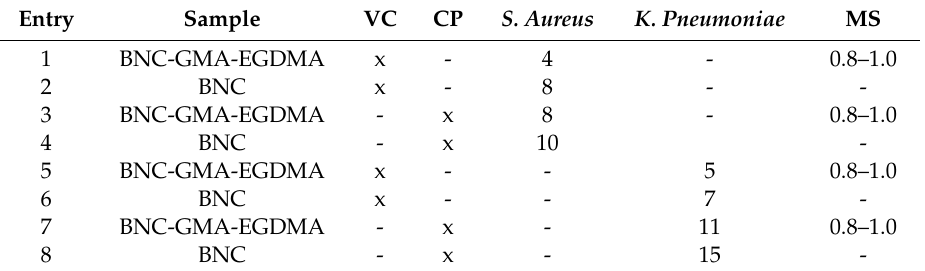
Figure 21. BNC and BNC-GMA-EGDMA MS = 0.8 antibacterial activity test. Left S. aureus , right K. pneumoniae . Upper VC, bottom CP. Table 5. BNC and BNC-GMA-EGDMA antibacterial activity test, inhibition zone in mm in Figure 21.